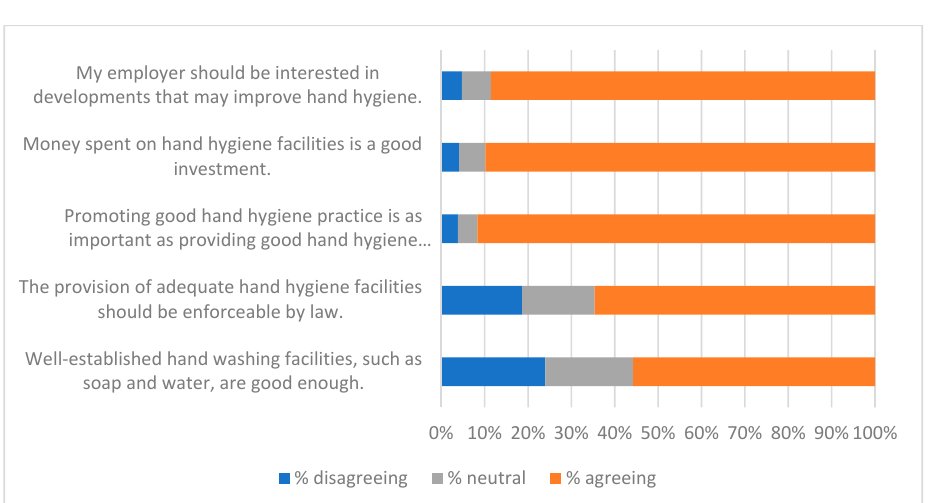
Figure 3. Promoting HH.